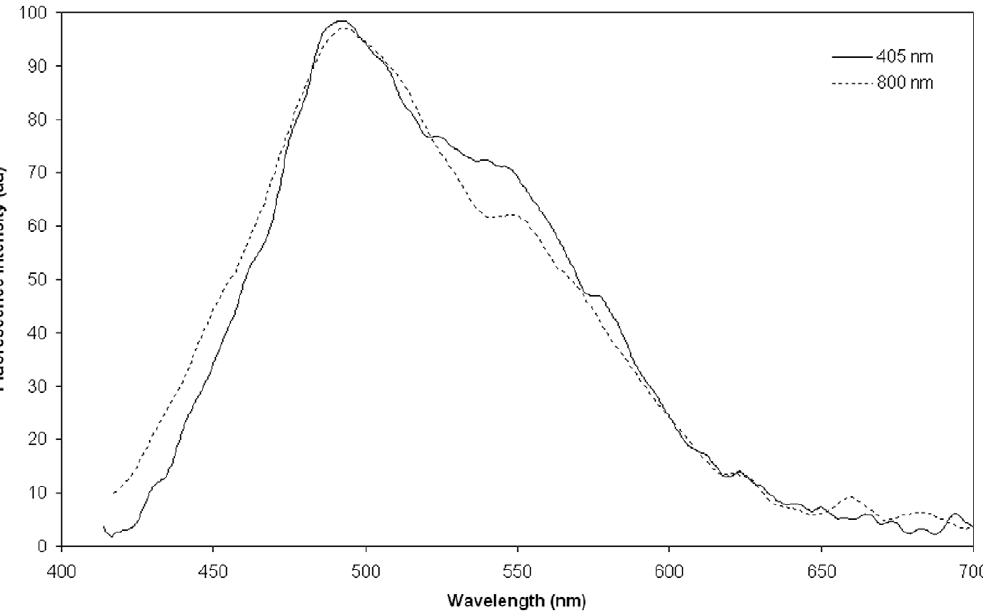
Figure 6. Fluorescence intensity profiles. Spectral characteristics of fluorescence from the human lens excited by 405 nm continuous-wave laser radiation (thin) and 800 nm femtosecond laser radiation (thick). Fluorescence was recorded at a 90 degree angle relative to the excitation laser beam and the differences in fluorescence emission spectrum for l ex at 405nm and l ex at 800 nm at the lower wavelengths are related to the 800 nm laser being focused at a greater distance from the detection source, i.e. a greater absorption of preferentially shorter wavelengths took place before the fluorescence emission reached the detector.